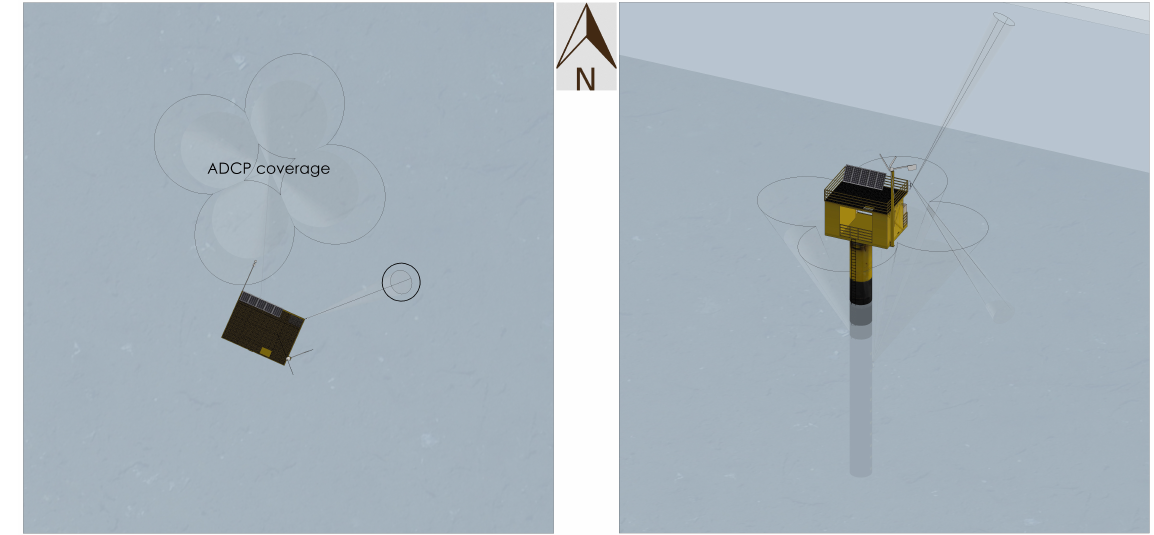
Figure 4. Schematic of the different measurement fields of view (FOV) of the sensors at the Time Series Station Spiekeroog at high water. Left panel: top view; right panel: perspective from south (provided by Nick